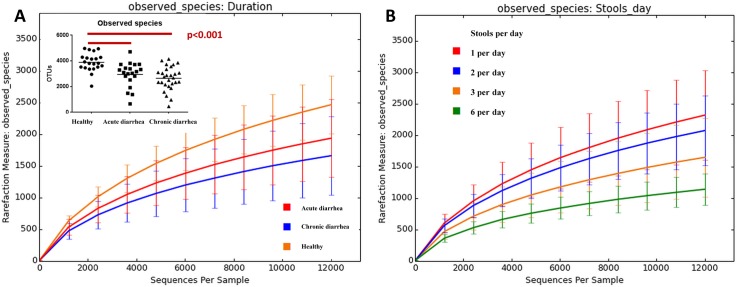
Rarefaction analysis of 16S rRNA gene sequences obtained from feline fecal samples.Lines represent the mean and error bars represent standard deviations. The analysis was performed on a randomly selected subset of 12,000 sequences per sample. (A) Analysis based on duration of diarrhea. (B) Analysis based on the number of stools per day.